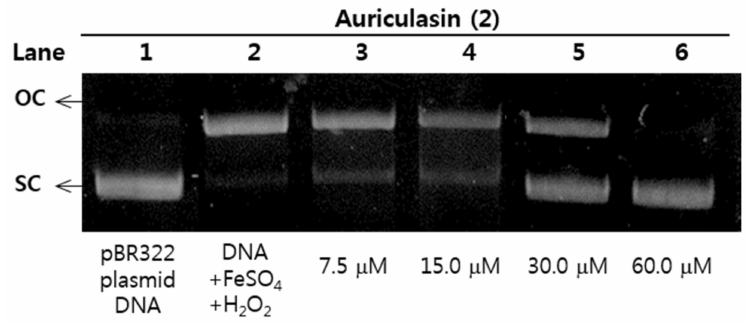
Figure 7. Dose-dependent protective effect of auriculasin ( 2 ) against pBR322 DNA cleavage induced by hydroxyl radical oxidative injury. Lane 1: pBR322 plasmid DNA control; lane 2: pBR322 DNA + 1 mM FeSO 4 + 30% H 2 O 2 ; lane 3: compound 2 , 7.5 µ M; lane 4: compound 2 , 15 µ M; lane 5: compound 2 , 30 µ M; lane 6: compound 2 , 60 µ